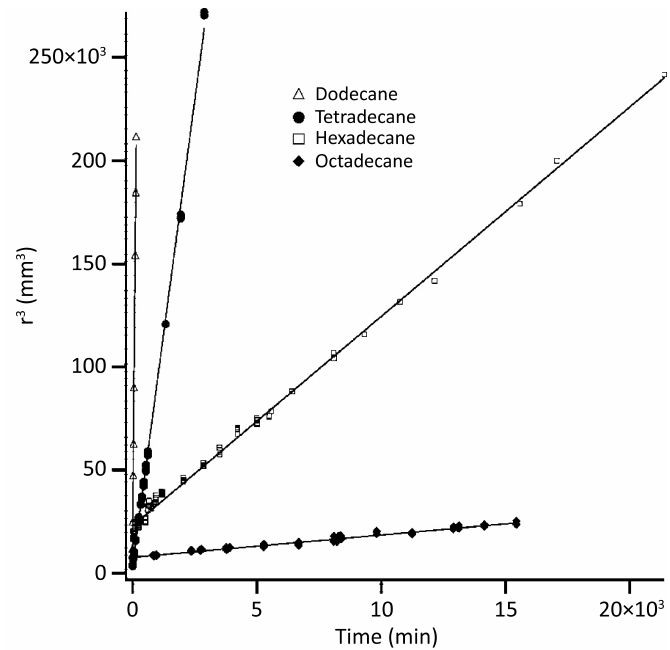
Figure 27. Ostwald ripening plots for alkane oil nanoemulsions stabilized using a SDS–polyethylene glycol (PEG) surfactant system. Figure reproduced from Ref.